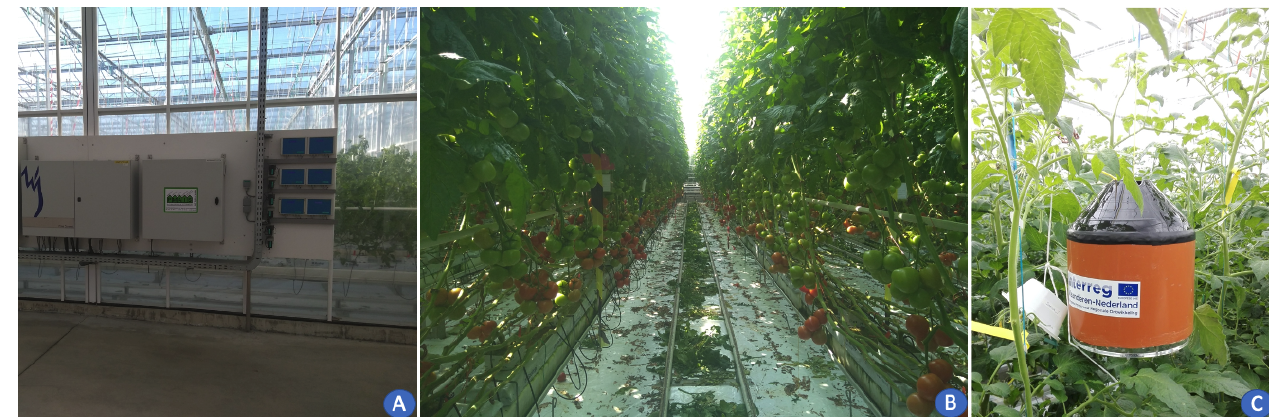
Figure 5. Greenhouse layout and sensor deployment in the greenhouse. ( A ) Complex infrastructure of the greenhouse. ( B ) Row of plants inside the greenhouse. ( C ) Sensor deployment in the greenhouse (air-flow (AF)